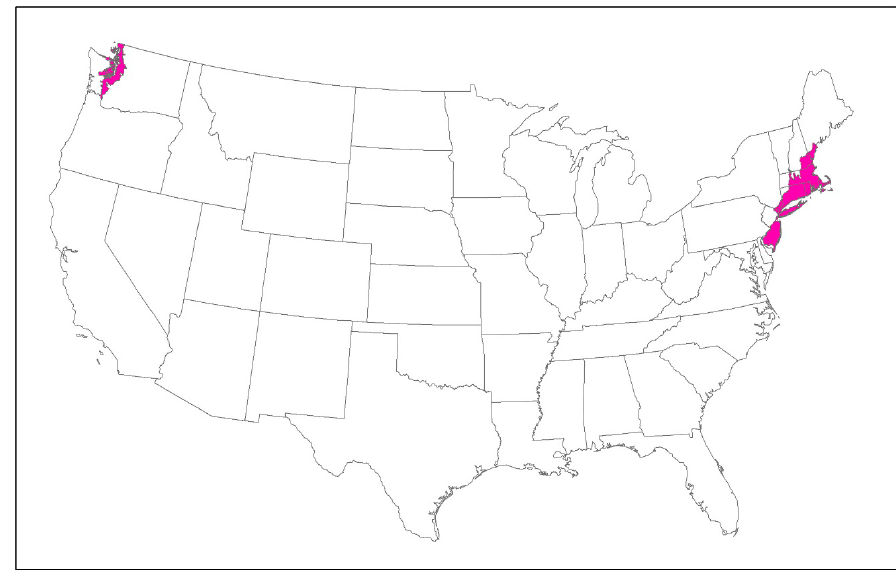
Figure 6. Ecoregions with a composite forest to urban developed land cover change score of 15 or greater. Puget Lowland and Atlantic Coastal Pine Barrens (ecoregions #2 and #84, respectively, in Figure 1) both had a score of 16, whereas the Northeastern Coastal Zone (ecoregion #59 in Figure 1) scored 15.